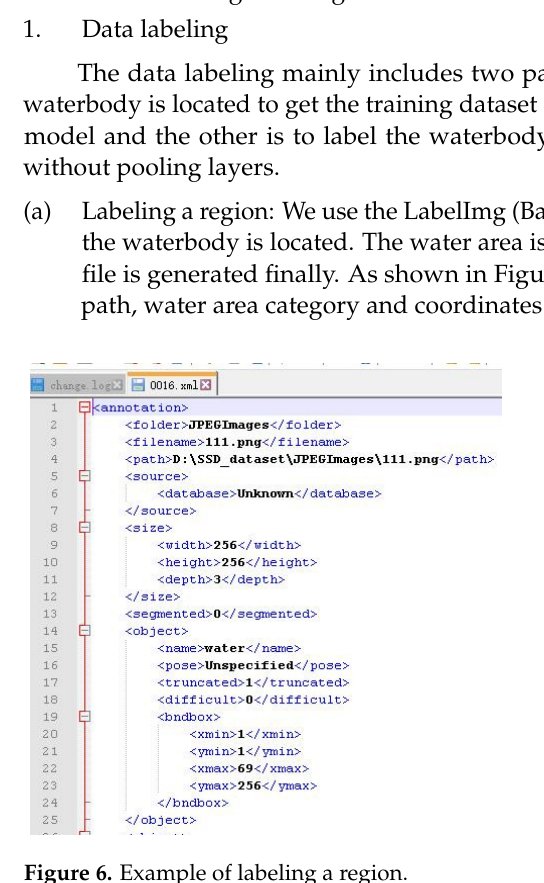
Figure 5. Image after band combination.